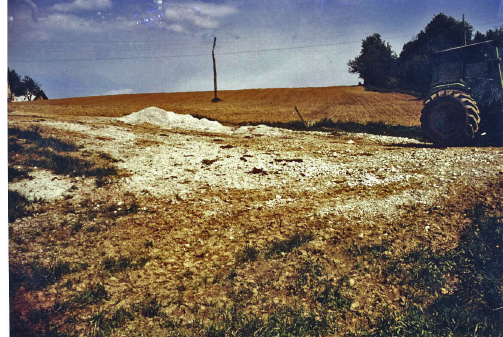
Figure 4: Part of pasture where > 300 m 3 of gravel from the mine was temporarily stored in 1992; on this location (behind the tractor) is also the drinking place for animal.